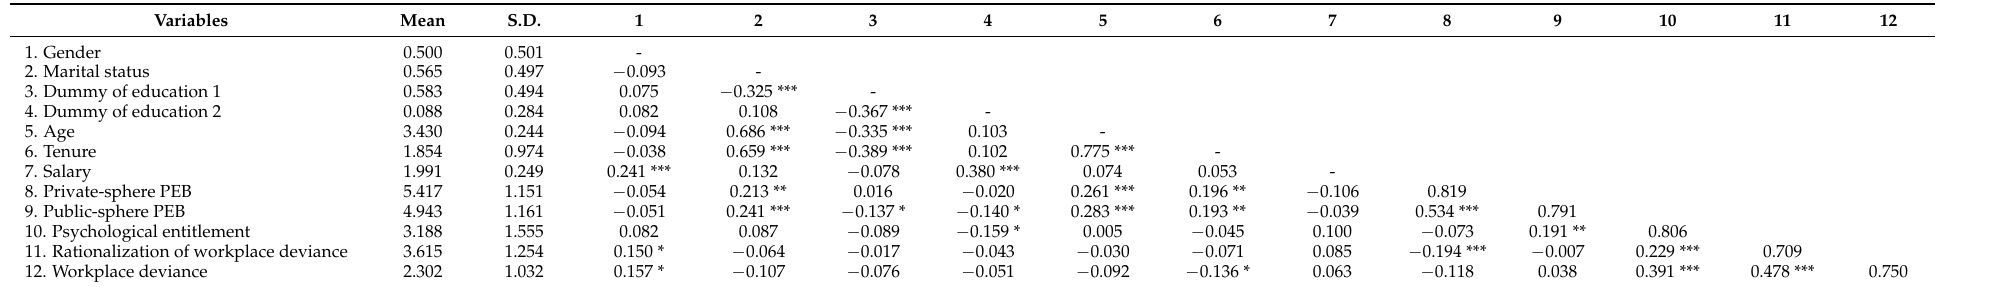
Table 2. Mean, standard deviations and correlations of the